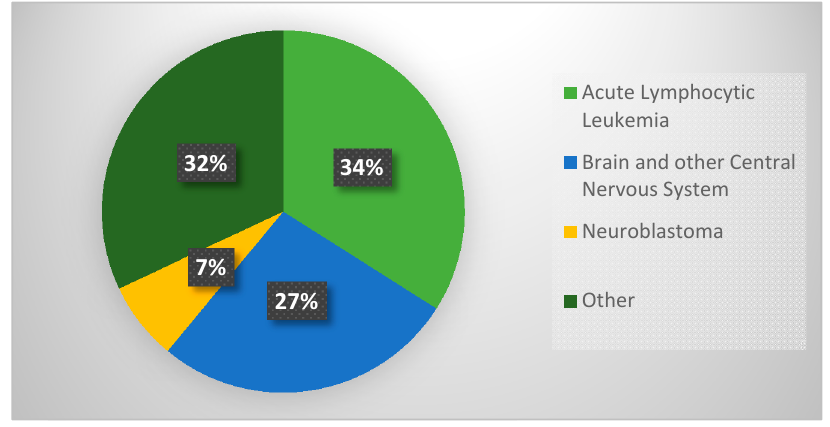
Figure 2. Childhood Cancers.